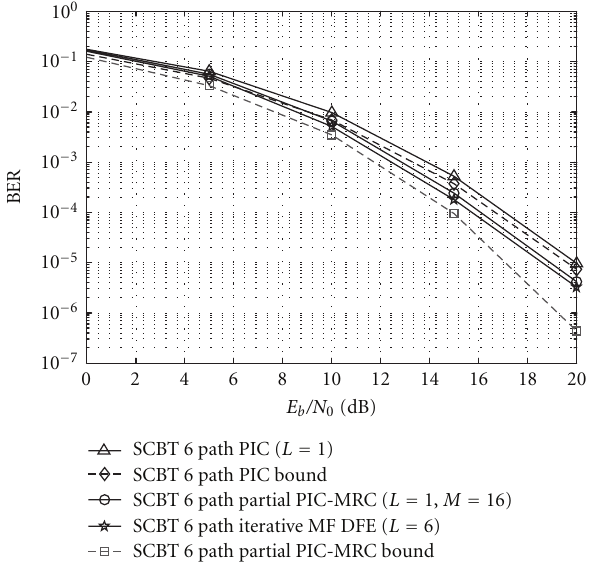
Figure 12: BER performance of PIC, partial PIC-MRC, and MMSE-DFE in SCBT system.